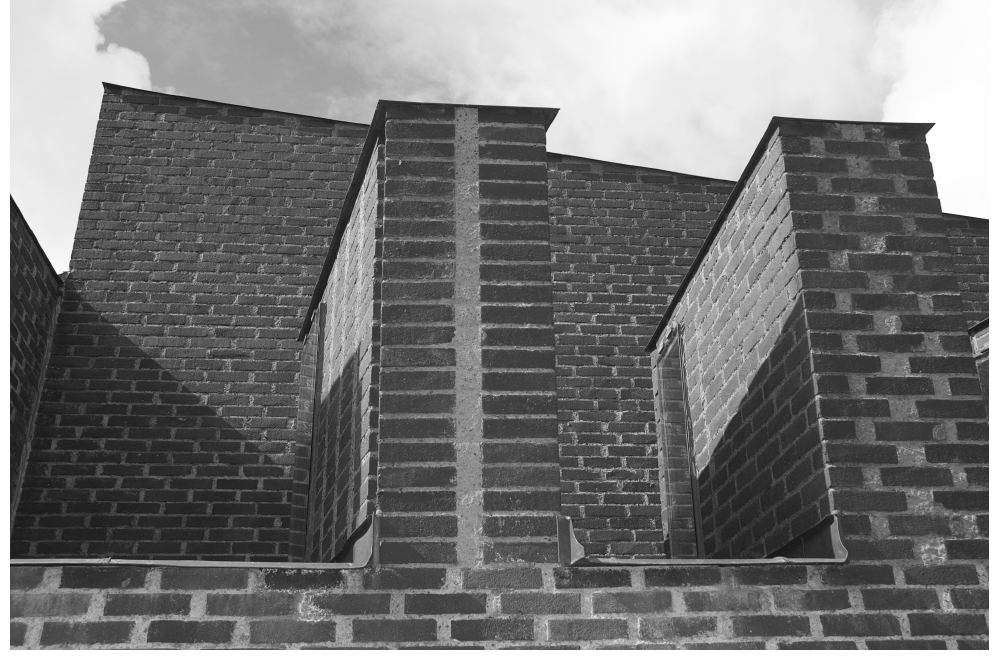
Figure 2: Rooflight